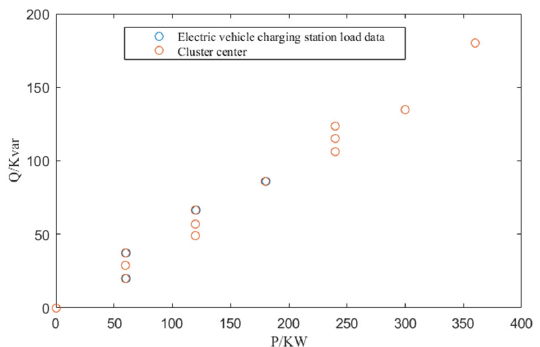
Figure 12. K ‐ means clustering results of electric vehicle charging stations with newly added random loads.